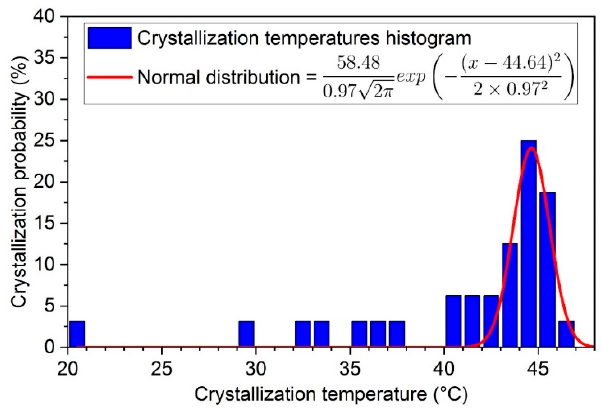
Figure 10. Probability distribution of crystallization temperatures for SAT60%.